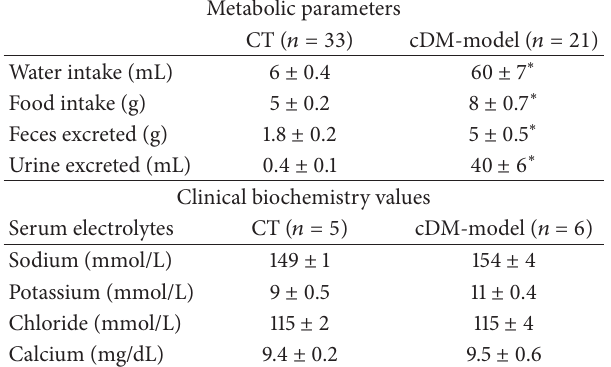
Table 1: Characterization of diabetes in cDM-model. Metabolic